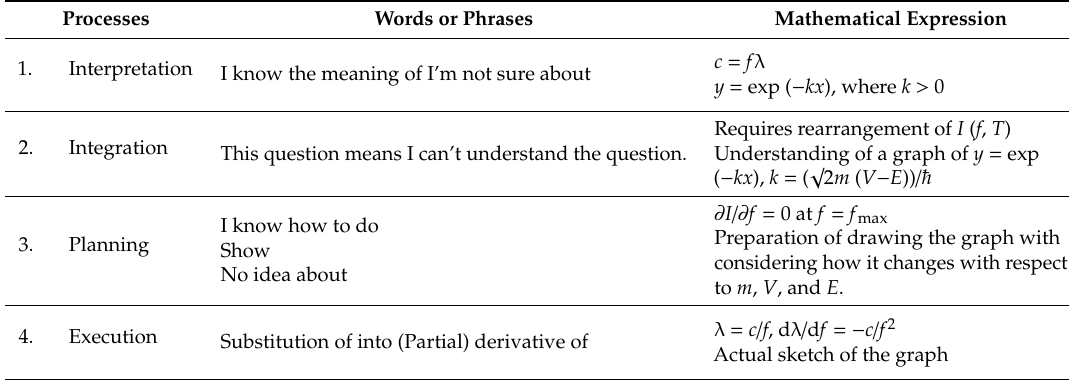
Table 2. Examples of words, phrases, and mathematical expression associated with coding four processes in solving transfer questions 1 and